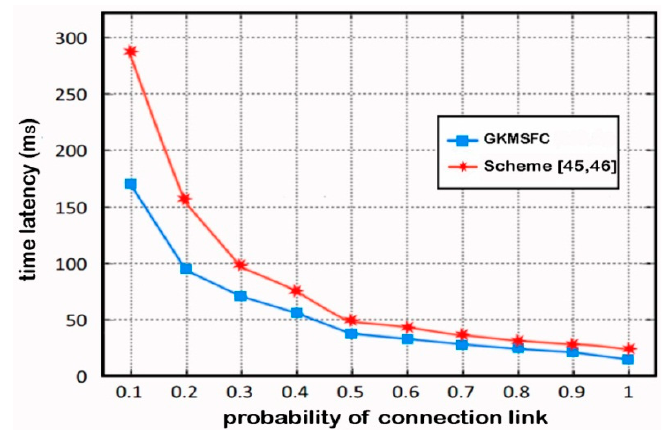
Figure 4. Rekeying success rate under different connectivity probability.